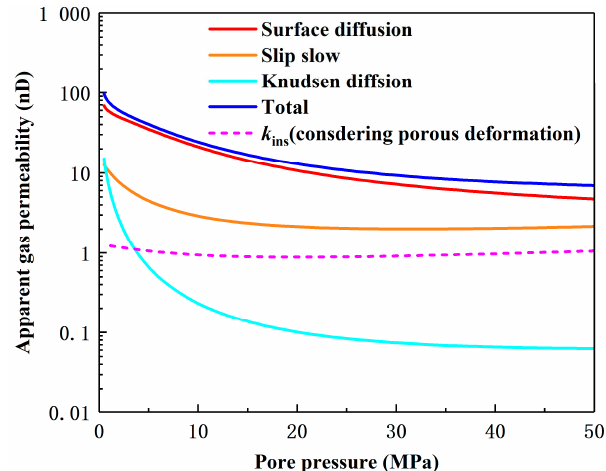
Figure 6. The apparent gas permeability (AGP) of different gas transport mechanisms varies with pressure ( r = 2 nm).